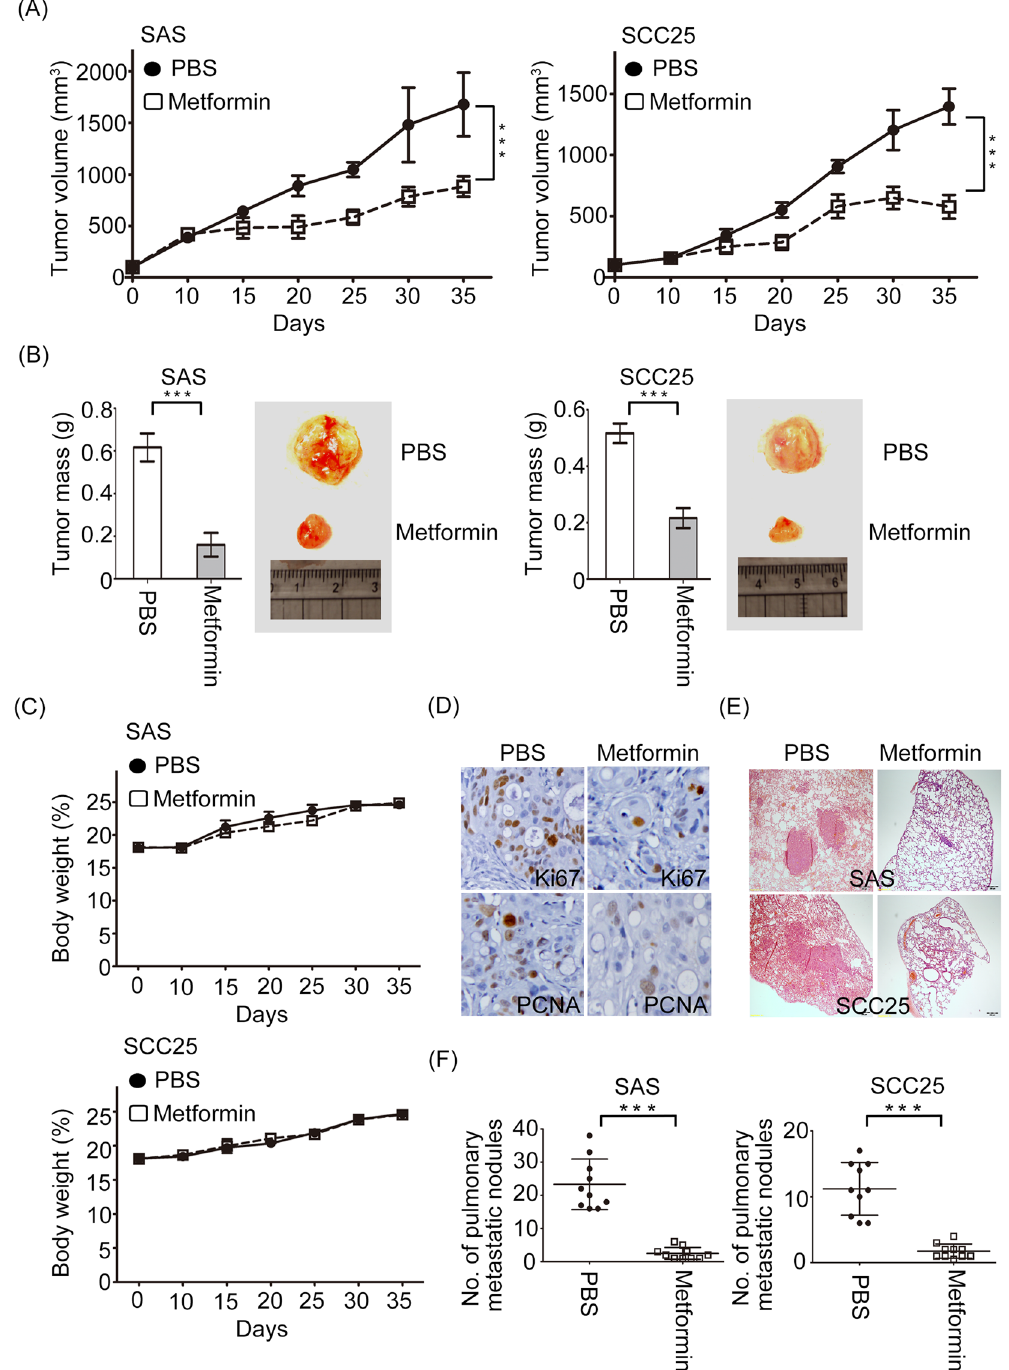
Figure 3. The effects of metformin on nude mice bearing SAS and SCC25 xenograft tumors. ( A ) Growth curves of xenograft tumors after the injection of SAS cells or SCC25 cells treated with PBS or metformin (5 mM) were measured. Tumor volume was evaluated at indicated times. ( B ) The effects of metformin on tumor mass. Tumor weight and representative tumors were measured and shown. ( C ) The body weights of mice were inspected during administration of metformin or control. ( D ) Representative images of expression levels of Ki-67 and PCNA in excised SAS-xenograft tumor tissues with metformin-treated mice or PBS group. ( E ) Representative images of lungs with HE-staining were isolated from mice that received tail vein injection of either SAS or SCC25 cells in the absence or presence of metformin treatment (5 mM). ( F ) The numbers of pulmonary metastatic nodules in the lung were counted and analyzed. All quantitative data are presented as mean ± SD. Data are represented as mean ± SD of three individual experiments. ( *** p <